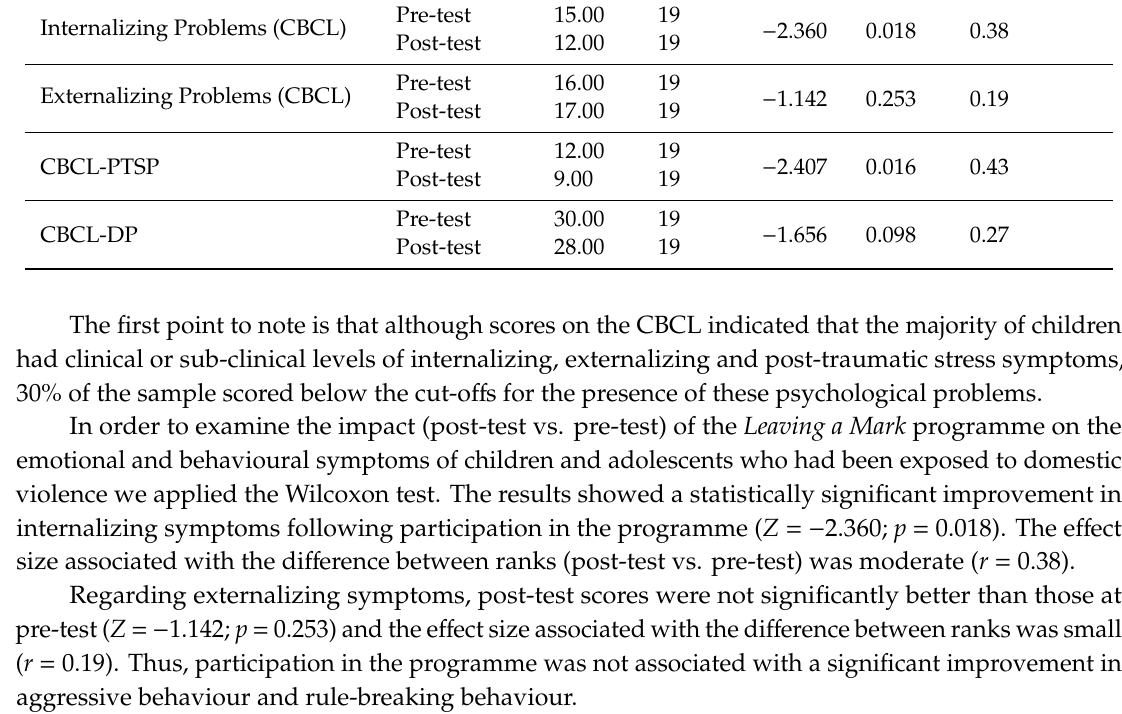
Table 2. Median scores at pre-test and post-test on the scales used to assess clinical symptoms, results of the Wilcoxon signed-rank test and e ff ect sizes associated with di ff erences between ranks. Variable Assessment Mdn. N Z Sig. E ff ect Size Pre-test 15.00 19 − Internalizing Problems (CBCL) 2.360 0.018 0.38 Post-test 12.00 19 Pre-test 16.00 Externalizing Problems (CBCL)